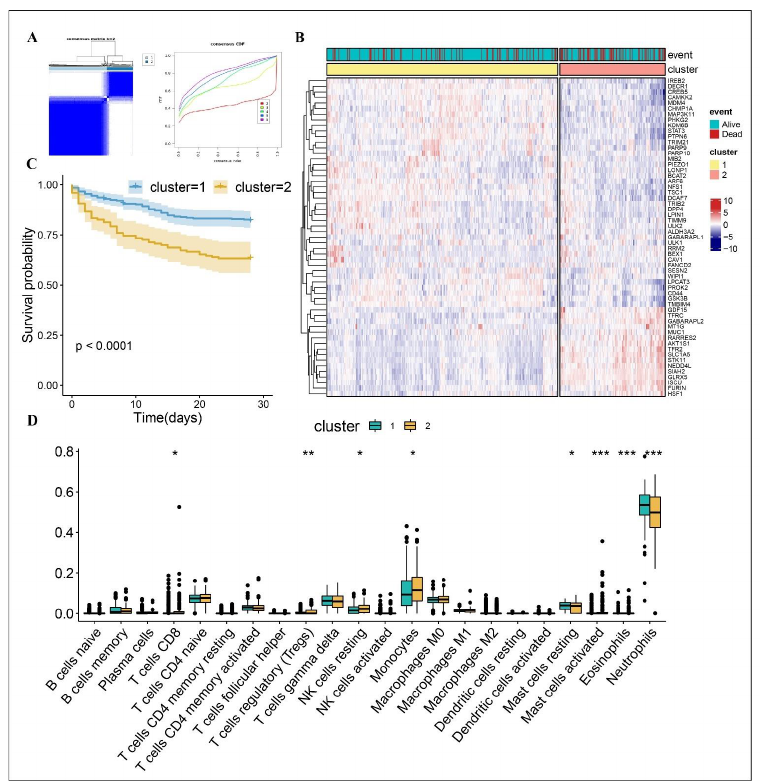
Figure 1. Consensus clustering and the different immune profiles between two clusters. ( A ) Consensus matrix heatmap indicating that the optimal value for consensus clustering is K = 2. ( B ) Heatmap visualizing the different expression pattern of the 57 FAGs in the two clusters. ( C ) Survival curve of the patients in the two clusters. ( D ) CIBERSORT analysis in the two clusters. * p < 0.05; ** p < 0.01; *** p < 0.001.